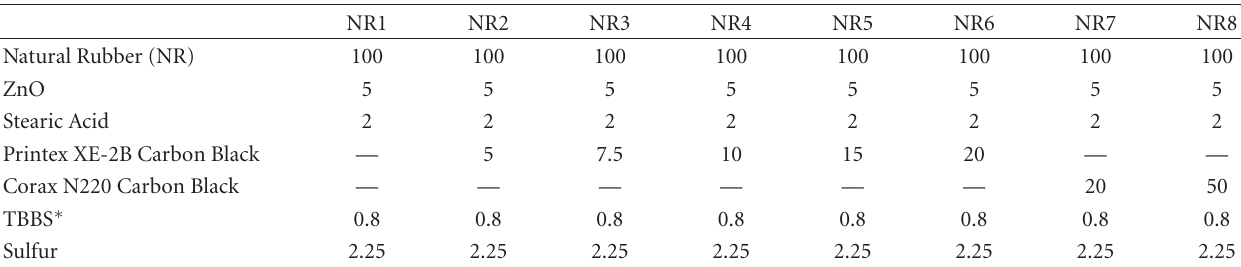
Table 2: Composition of the rubber compounds studied.